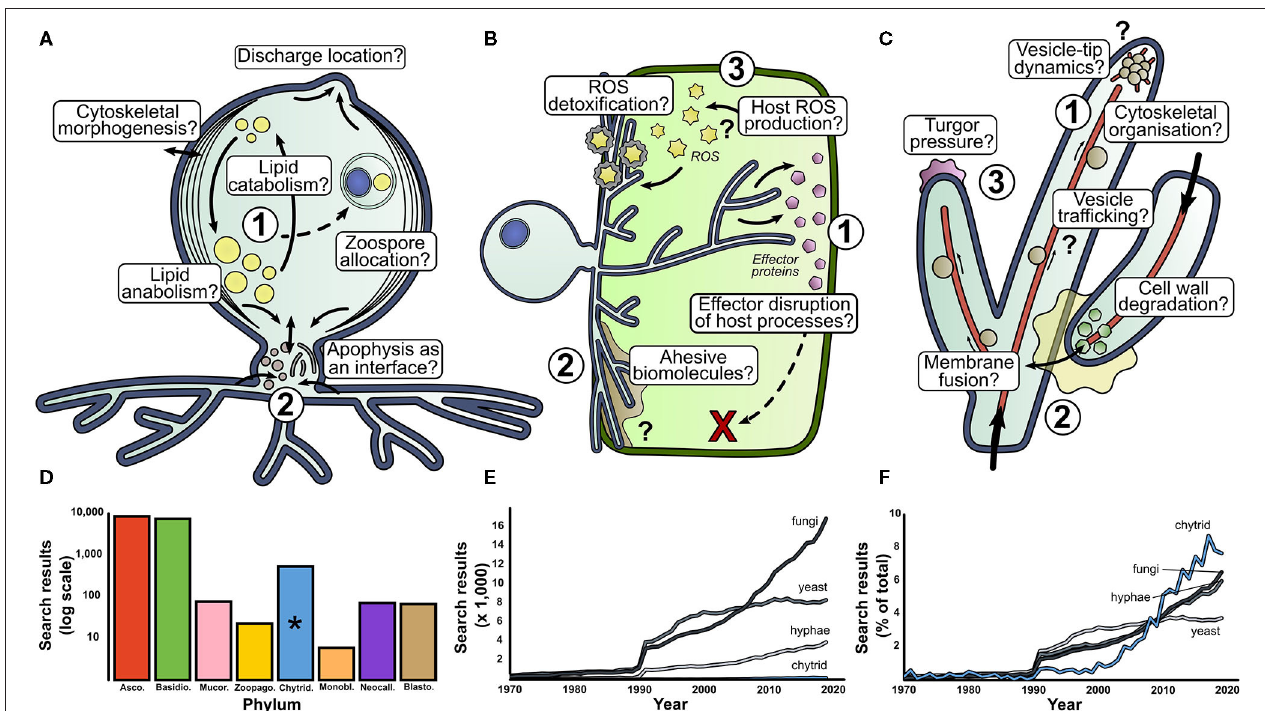
FIGURE 2 | There are many fundamental questions outstanding in basic aquatic chytrid biology. Our perspective for research directions in aquatic chytrid biology concerning (A) cell development and lipid production, (B) chytrid-host interaction and (C) rhizoid biology. Question marks indicate biological processes whose presence and function are speculative. (D) Web of Science (WoS) counts for fungal phyla search terms since 1970. (E) WoS for search terms associated with mycology. Chytrids suffer low representation next to other mycological terms. However, when scaled as a percentage of total results, chytrids have experienced a sharp increase in attention in the past couple of decades (F) . *phylum